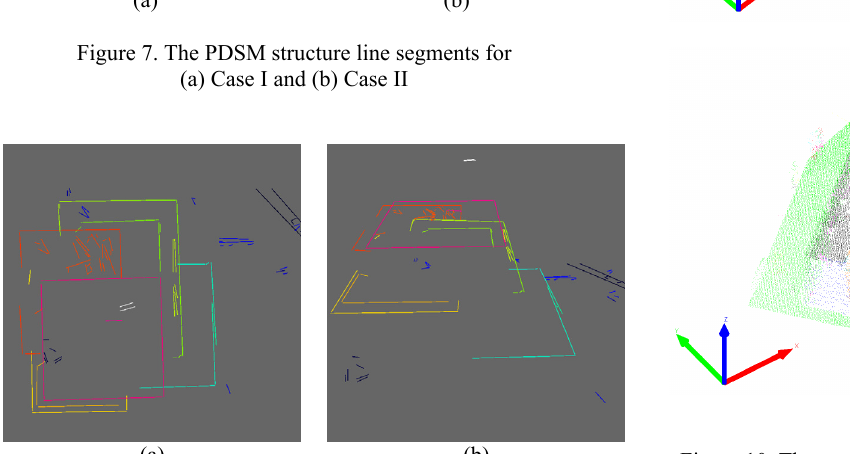
Figure 10. The octree-based segmentation results for